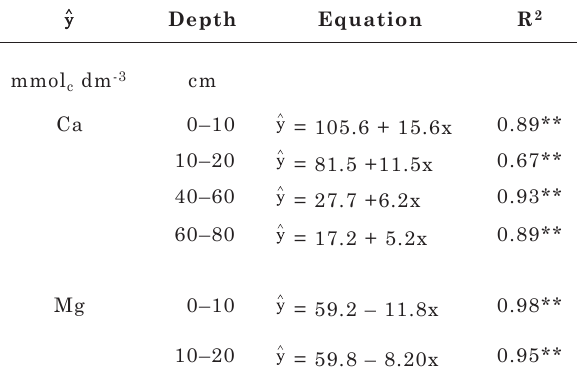
table 1. regression equations with significant co- efficients of determination (p ≤ 0.01) between exchangeable Ca and mg in the soil ( ), for different depths, and annual gypsum rates (x), broadcast on the soil surface from 2001 to